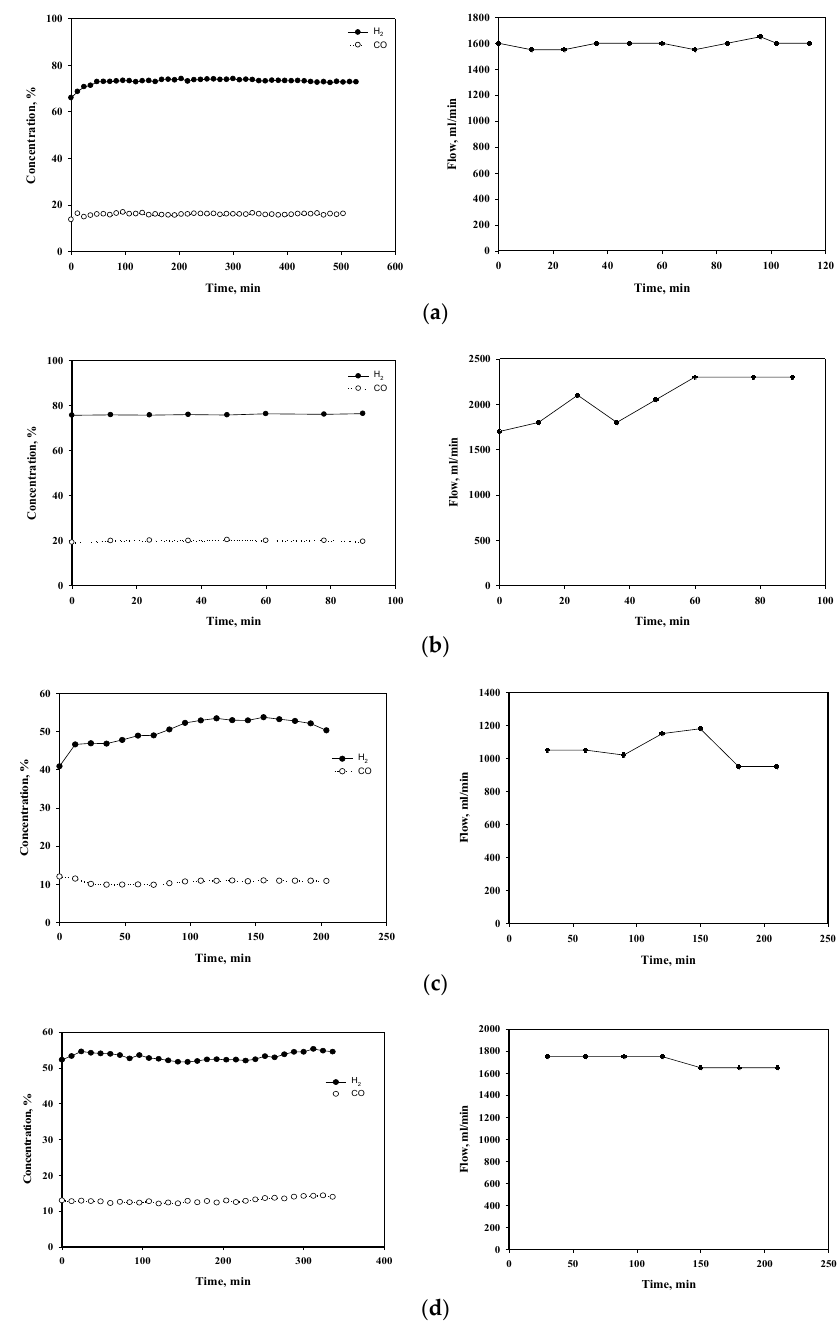
Figure 1. Concentration of H 2 and CO in the reformate gas and the dry gas flow rates obtained by steam and auto-thermal reforming of toluene over Ni-based catalysts. ( a ) Steam reforming of toluene (S/C = 3.0) at 750 °C; ( b ) steam reforming of toluene (S/C = 3.0) at 800 °C; ( c ) auto-thermal reforming of toluene (S/C = 3.0, O 2 /C = 0.2) at 750 °C; ( d ) auto-thermal reforming of toluene (S/C = 3.0, O 2 /C = 0.2) at 800 °C. In actuality, the measured flow rate of the dry gas was half of the theoretical maximum flow rate; however, an oil component could not be confirmed in the condenser at the downstream portion of